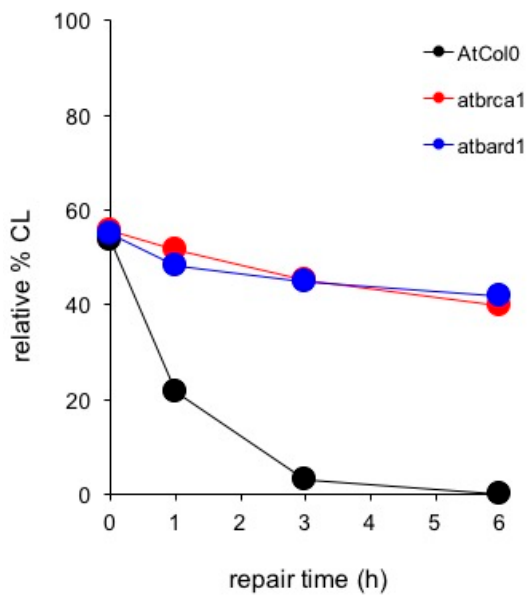
Figure 10. Comet assay depicting DNA damage repair in wild-type Arabidopsis thaliana (AtCol0) and the knockout DNA repair mutants atbrca1 and atbard1 following treatment with 200 μ M Mitomycin C and post-treatment recovery for 1, 3 and 6 h.